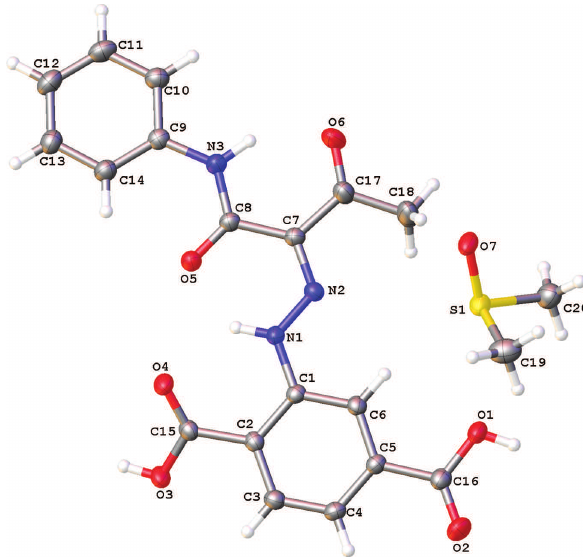
Table 1: Data collection and